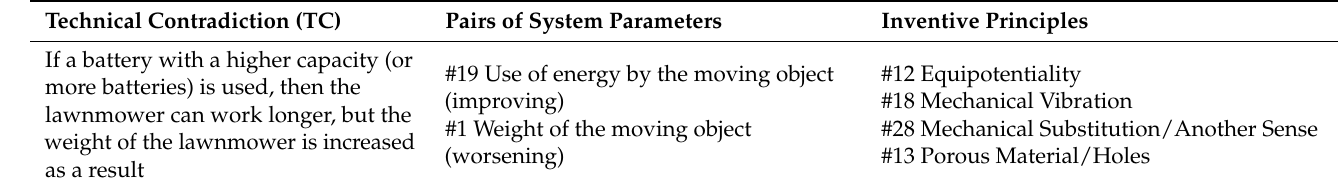
Table 8. Inventive principles from system parameters of technical contradictions (constraint 2).